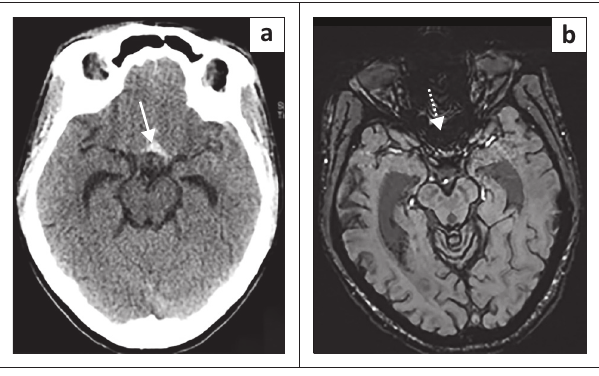
NECT, non enhanced CT; SWI, susceptibility weighted imaging. FIGURE 3: The NECT and SWI in patient with a ruptured anterior communicating aneurysm. Subarachnoid haematoma (a. white arrow) in the suprasellar cistern is not appreciated on the 3 month SWI because of adjacent susceptibly artefact from the base of skull (b. white dashed arrow).